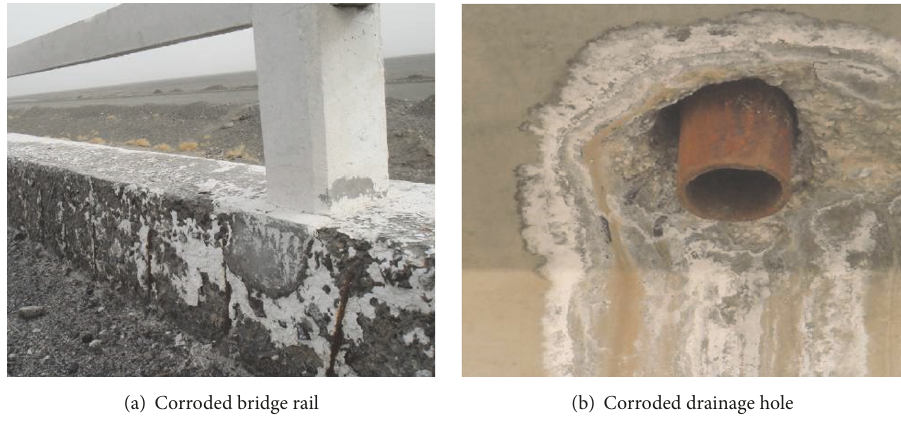
Figure 1: Corrosion of roadside structures in